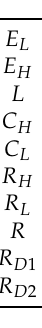
Table 2. System data.